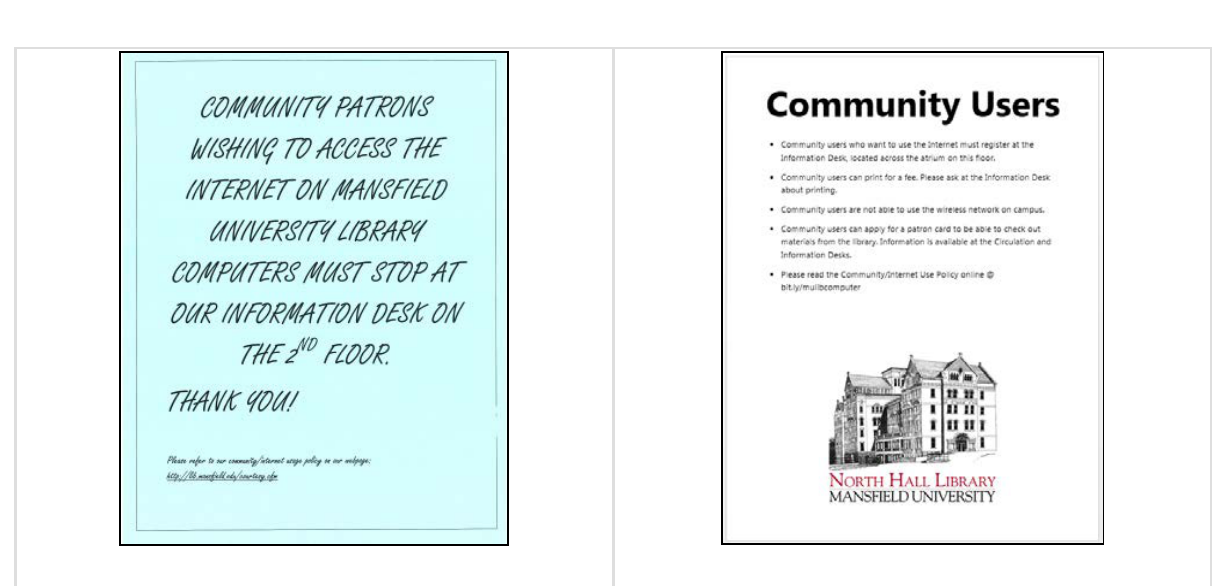
The original sign (left) uses all caps and a script font. It is difficult to identify from a distance that this sign is only for a small number of library users. The use of colored paper does not add anything to the design. The new sign (right) uses a larger headline to tell relevant patrons that there is information for them. Others can see that they may ignore the sign.